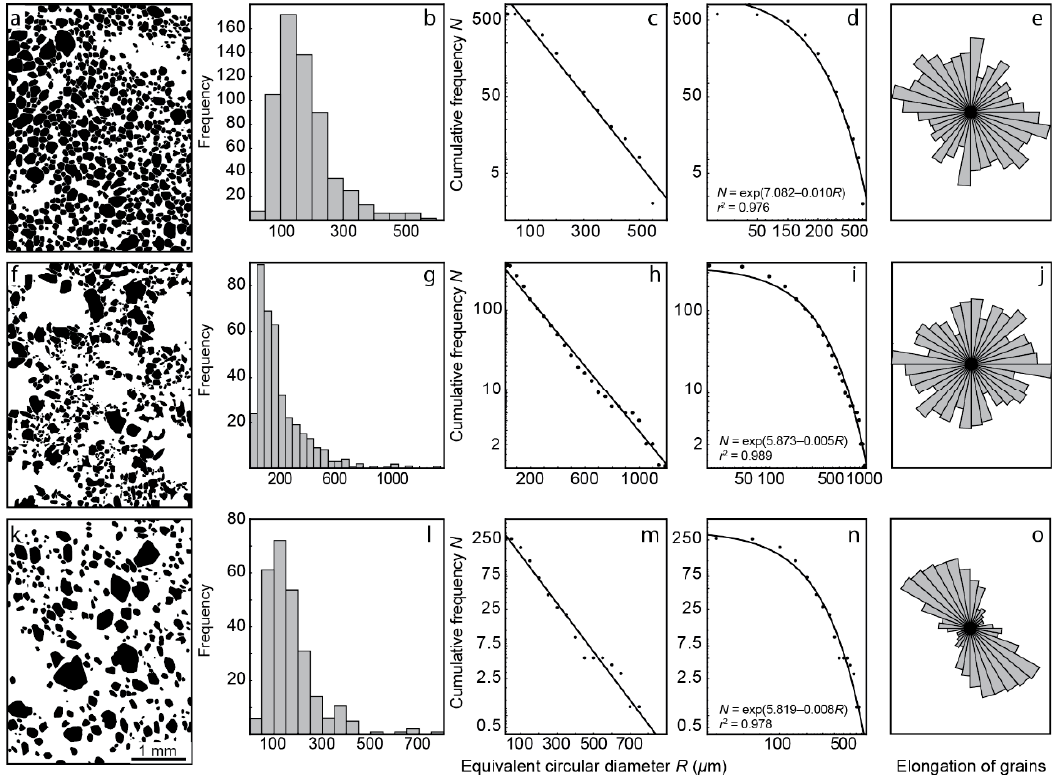
Figure 4. Distribution of forsterite content ( a ) and average grain size ( b ) within the baddeleyite-apatite-magnetite deposit.